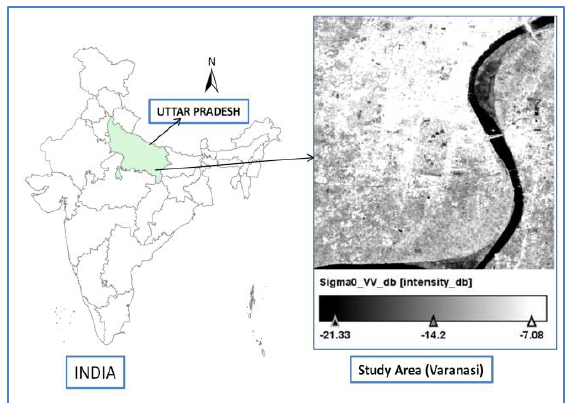
Figure 1. Location of study area with Sentinel-1A image